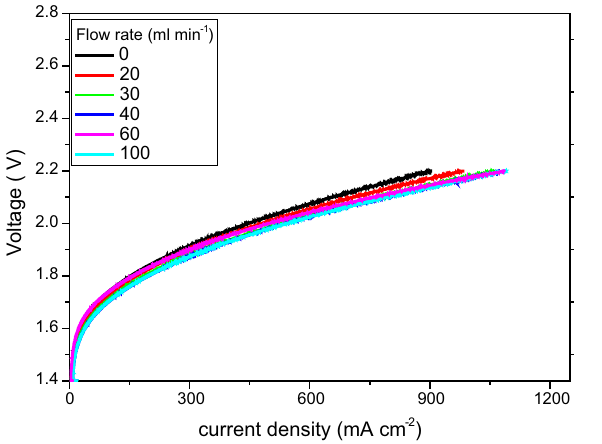
Figure 5. Polarization curves of an AEM electrolyser, recorded for different flowrate of KOH electrolyte, at 60 °C.